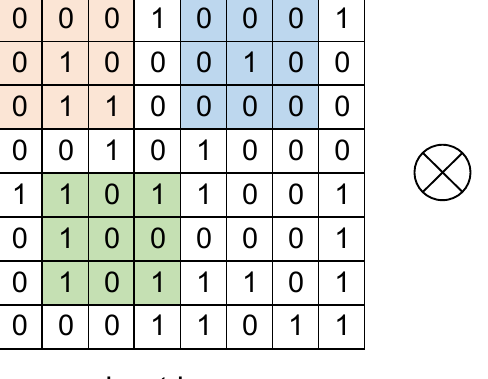
Figure 4. Diagram of operations performed by the convolutional layer.